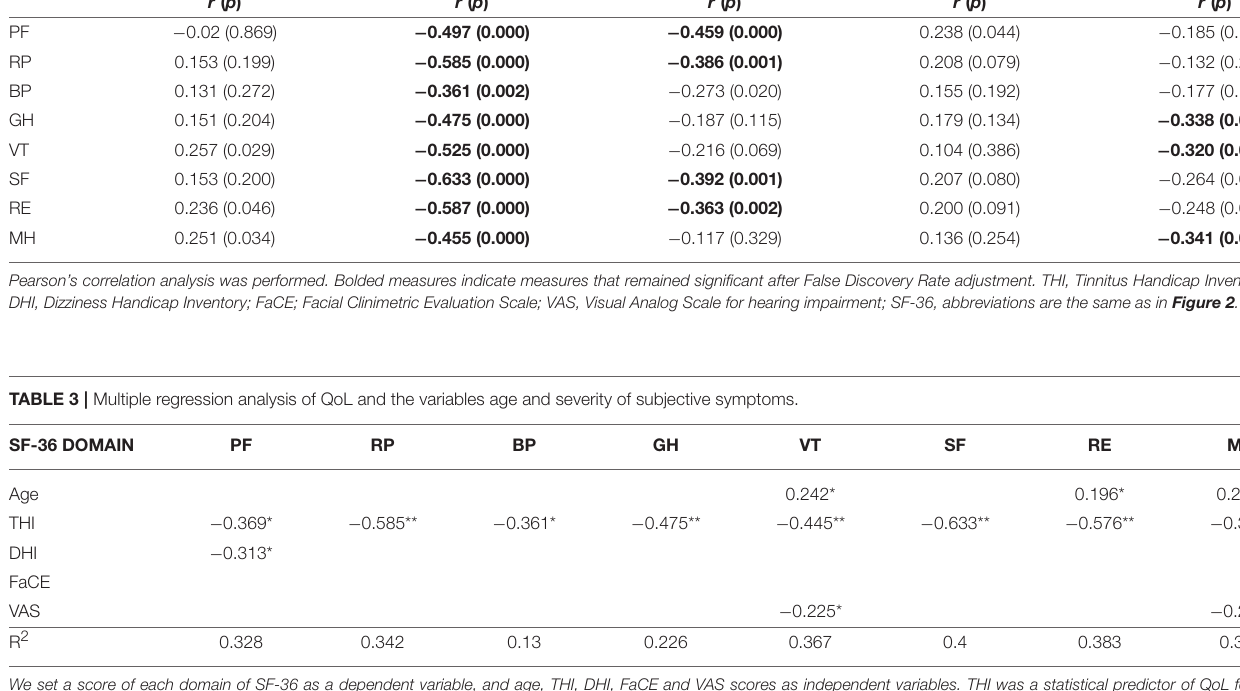
TABLE 2 | Correlation results (Pearson correlation coefficients) from the assessment of the relationship between SF-36 domains and age and subjective symptoms. Age